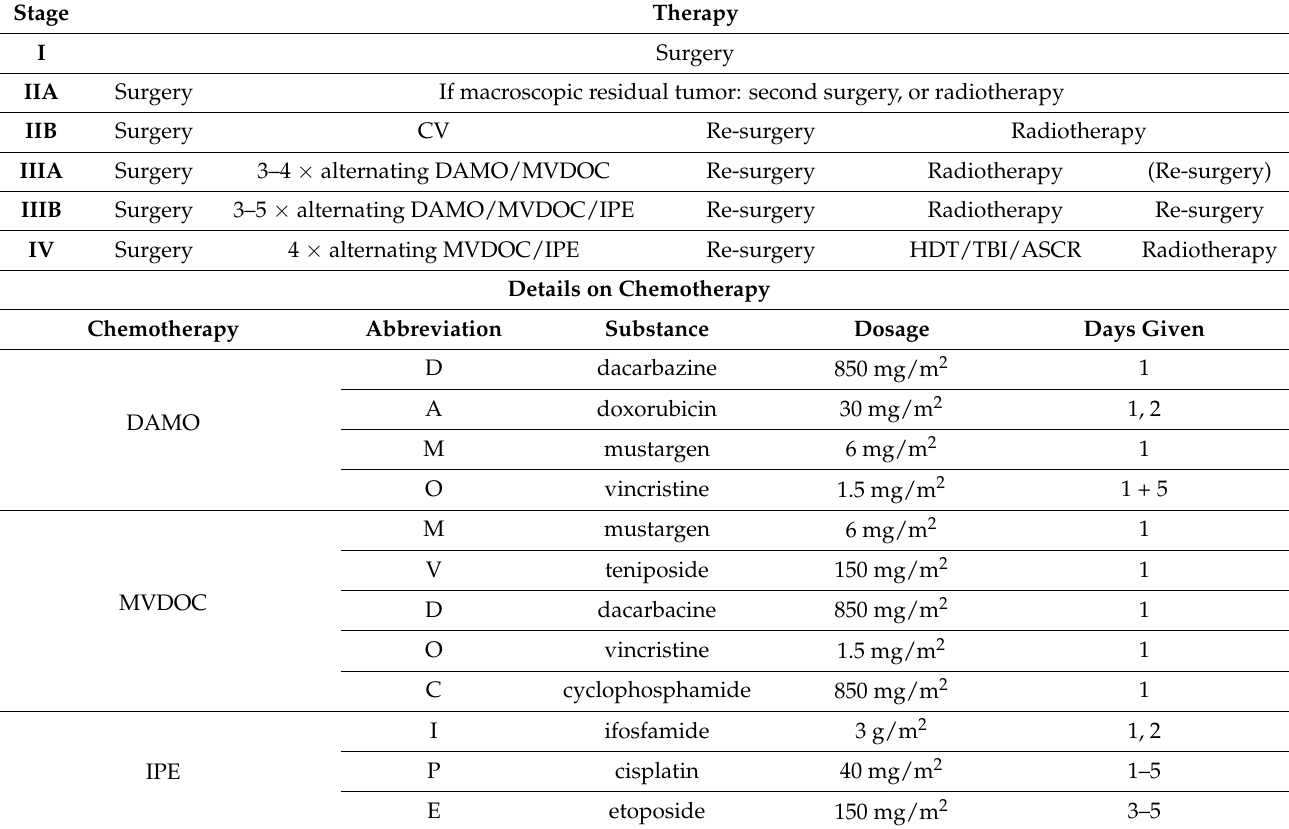
Table A3. Chemotherapy elements and treatment regimens used in the A-NB87